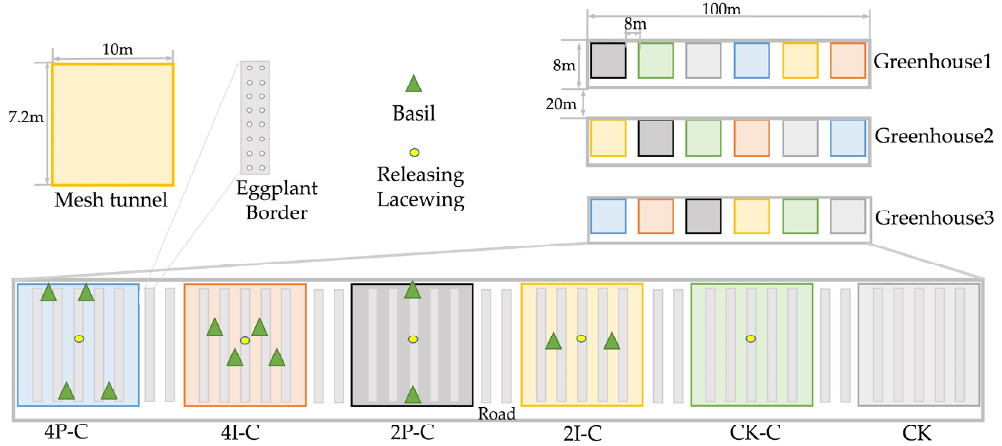
Figure 1. Illustration of the experimental design of the enhancement effect of basil O. basilicum on the lacewing C. pallens in colonization and pest suppression in a greenhouse. Each greenhouse was 100 m × 8 m and divided into 6 10 m × 7.2 m mesh tunnels. The spacing between the mesh tunnels was 5 m. The six colors of the mesh tunnels indicate the different treatments: 4P-C, four basil plants placed around the perimeter of the eggplant, with five pair of lacewing adults released; 4I-C, four basil plants intercropped with the eggplant, with lacewing adults released; (3) 2P-C, two basil plants placed around the perimeter of the eggplant, with lacewing adults released; (4) 2I-C, two basil plants intercropped with the eggplant, with lacewing adults released; (5) CK-C, no basil plants, with lacewing adults released (control-C); and (6) CK, no basil plants and no lacewing